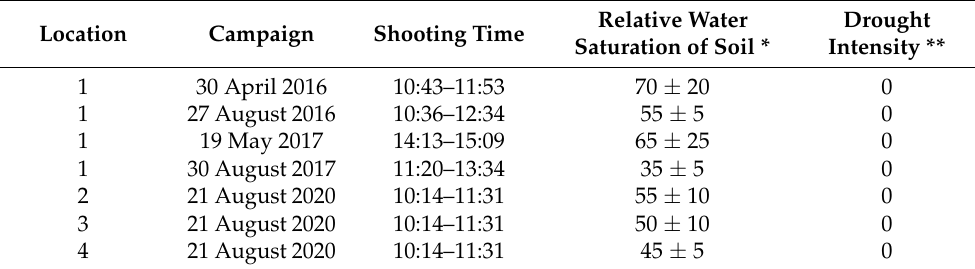
Table 1. Soil wetness of individual locations about one week before aerial imaging (INTERSUCHO. Available online: https://www.intersucho.cz/ (accessed on 12 December 2022)).